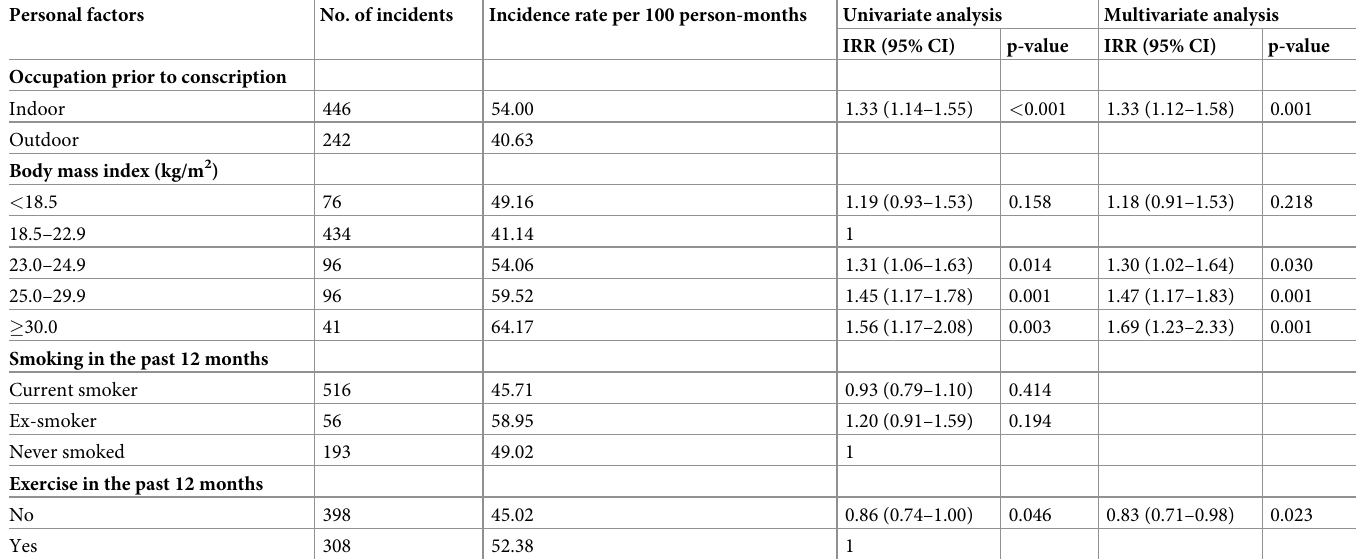
Table 5. Personal risk factors associated with body weight loss of more than 3% in one day among new conscripts during basic military training. Personal factors